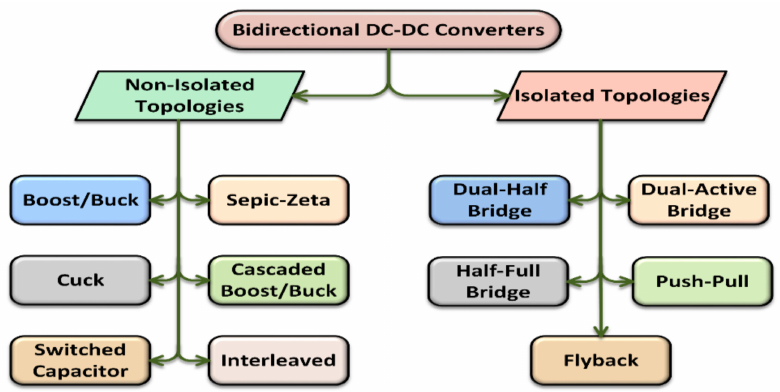
Figure 3. Classification of bidirectional DC-DC converters.